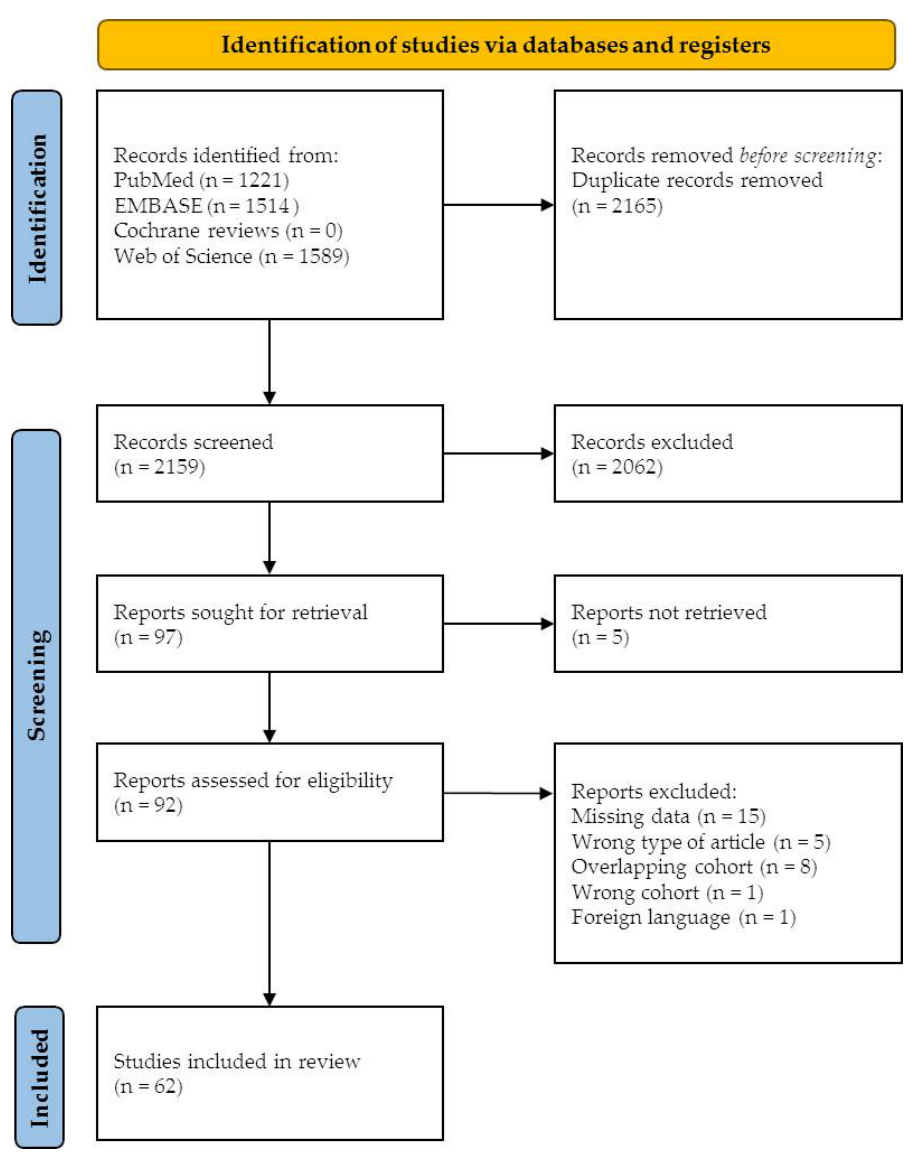
Figure 1. Identification of studies via databases.